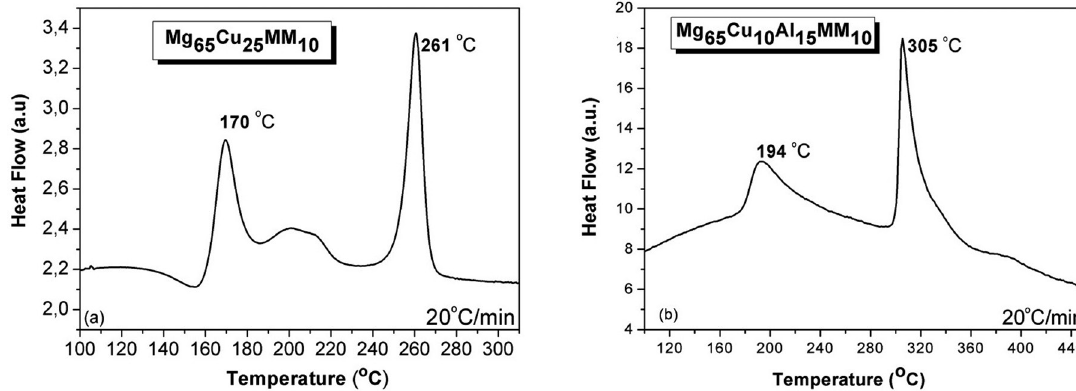
Cu MM and Mg 65 25 10